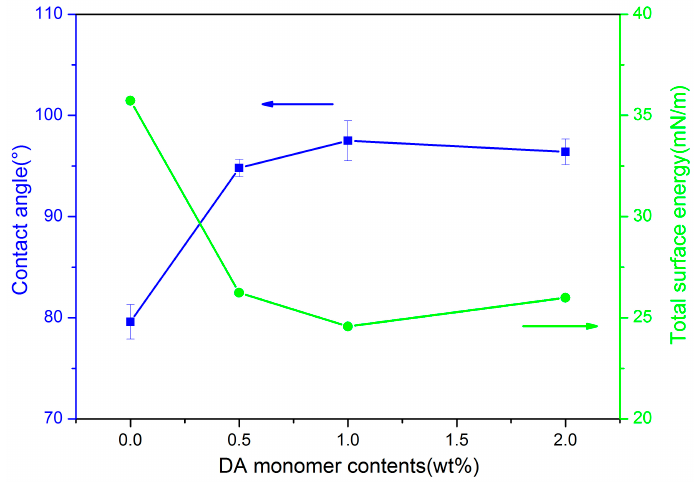
Figure 8. Water contact angles and total surface free energy as functions of DA monomer contents.